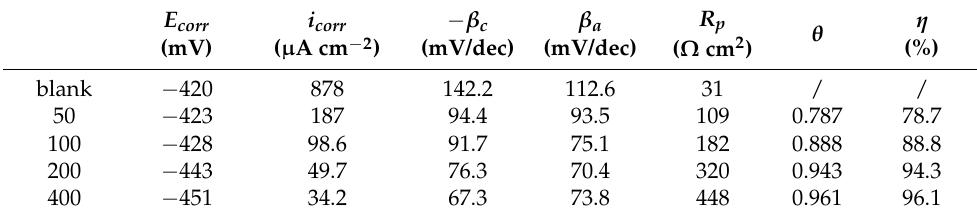
Figure 6. ( a ) The potentiodynamic polarization plots of Q235 carbon steel in 1 M HCl solution in the absence and presence of NCDs, and ( b ) Langmuir adsorption plot obtained from potentiodynamic polarization plots of Q235 carbon steel in the absence and presence of NCDs. Table 2. Electrochemical parameters obtained from the potentiodynamic polarization plots.